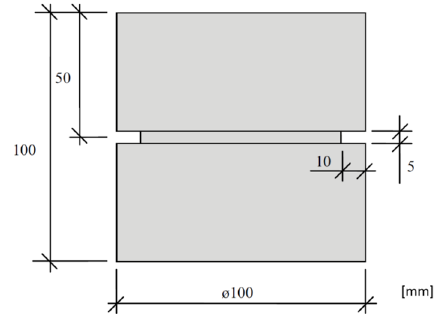
Figure 4. Uniaxial tensile test specimen geometry.